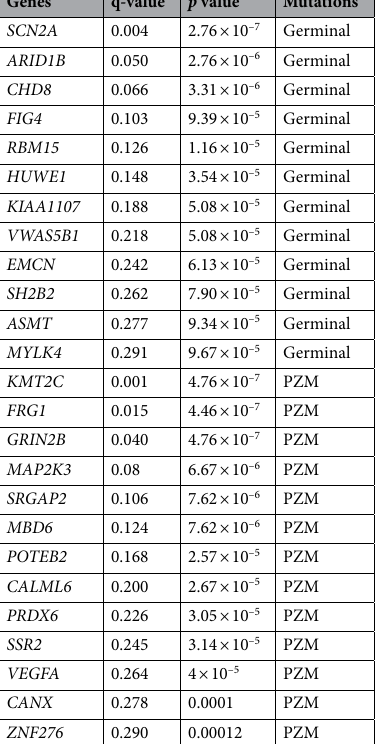
Table 1. ASD risk genes carrying germinal DNMs and PZMs in the Spanish cohort. p values and q-values were obtained after running TADA-Denovo using germinal DNMs and PZMs from the Spanish ASD cohort (N = 360). Only genes with q-values < 0.3 are